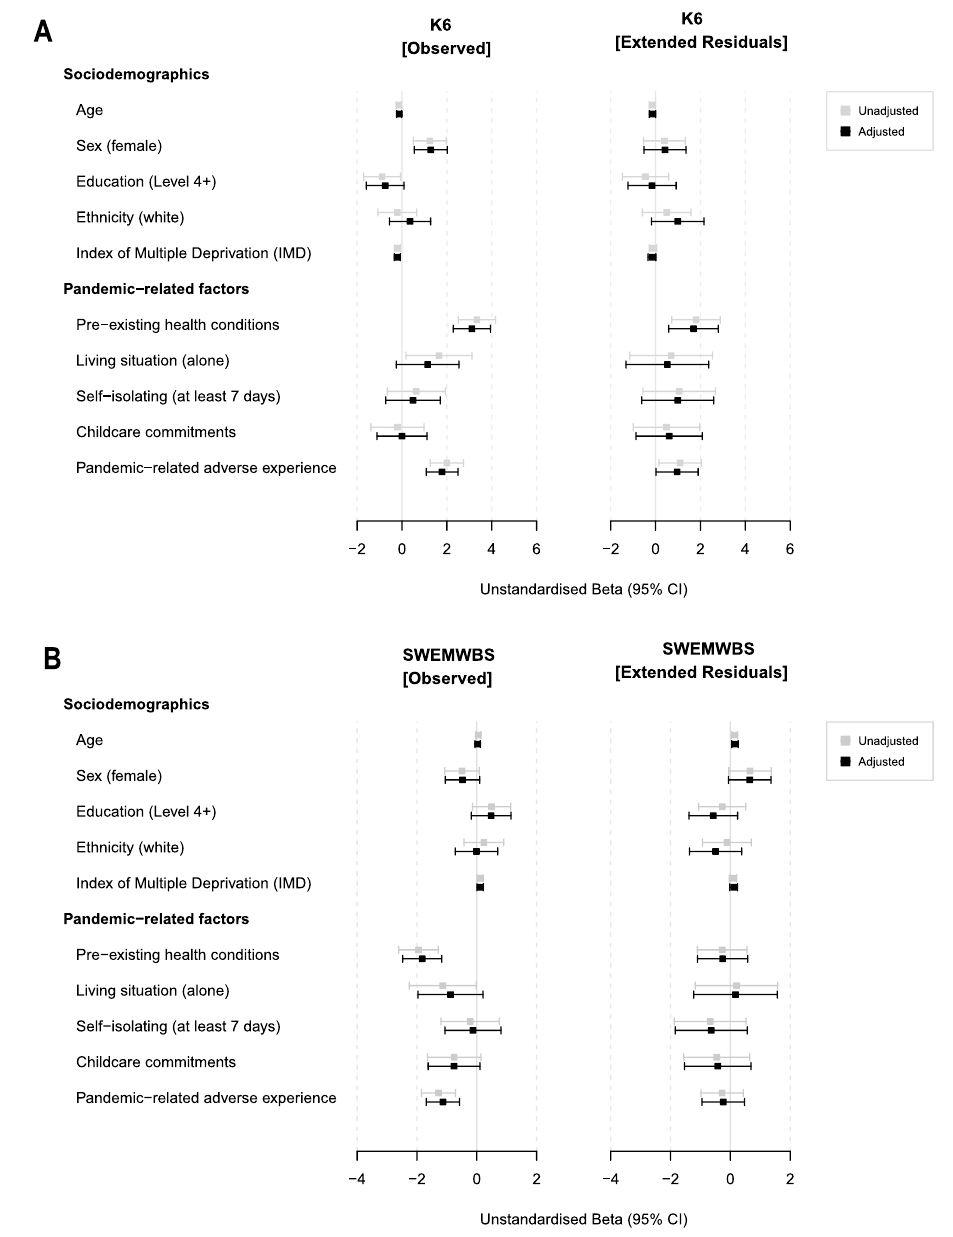
Figure 5. Unstandardised beta coefficients and their 95% confidence intervals for linear models assessing sociodemographic as well as pandemic-related risk factors for both primary outcome measures; the Kessler Psychological Distress Scale ( A ) and the Short Warwick-Edinburgh Mental Wellbeing Scale ( B ). The left panel shows coefficients for the observed scores at Assessment 4 whilst the right panel shows extended residual scores which take into account individual pre-pandemic